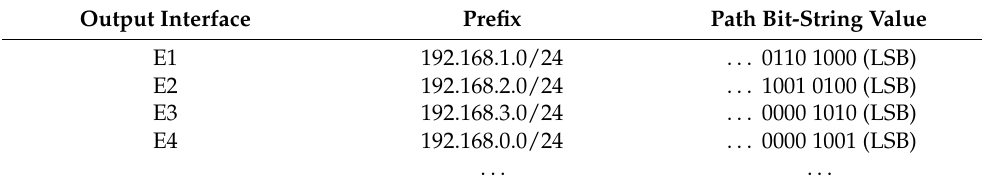
Table 5. EB-REP Backup Table on